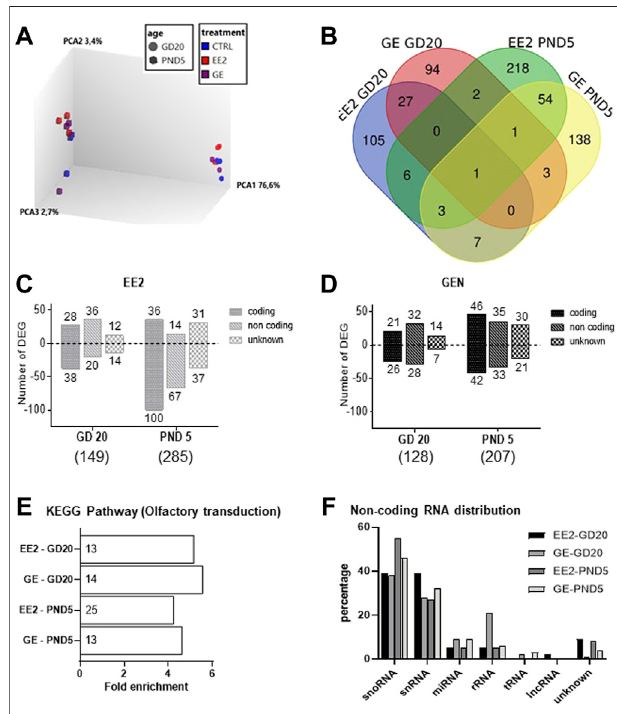
FIGURE 4 | Analysis of microarray data for germ cells gene expression after in utero exposure to EE2 or GE. (A) 3D PCA plot of all samples representing the global differential gene expression patterns in GFP-positive sorted cells after treatment at the two sampling ages (B) Total numbers ofdifferentiallyexpressed genes(DEGs)andoverlapsafterexposuretoEE2or GE at the two sampling stages. (C) Numbers of up- and down-regulated DEGsafterexposuretoEE2atthetwosamplingages (D) Numbersofup-and down-regulated DEGs after exposure to GE at the two sampling ages. (E) Enrichment analysis revealing common enrichment for the KEGG pathway rno04740- Olfactory transduction (the number of DEGs is speci fi ed for each treatment group and stage, in each histogram bar) (F) Distribution of DEGs according to non-coding RNA types, in the different treatment and age